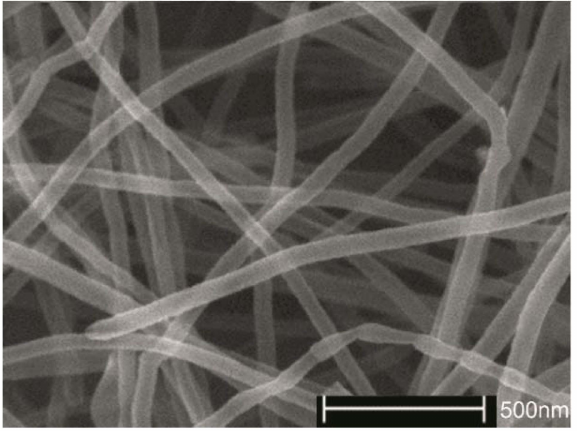
scanning electron microscope (SEM) image of raw multi-walled carbon nanotube (MWCNT)